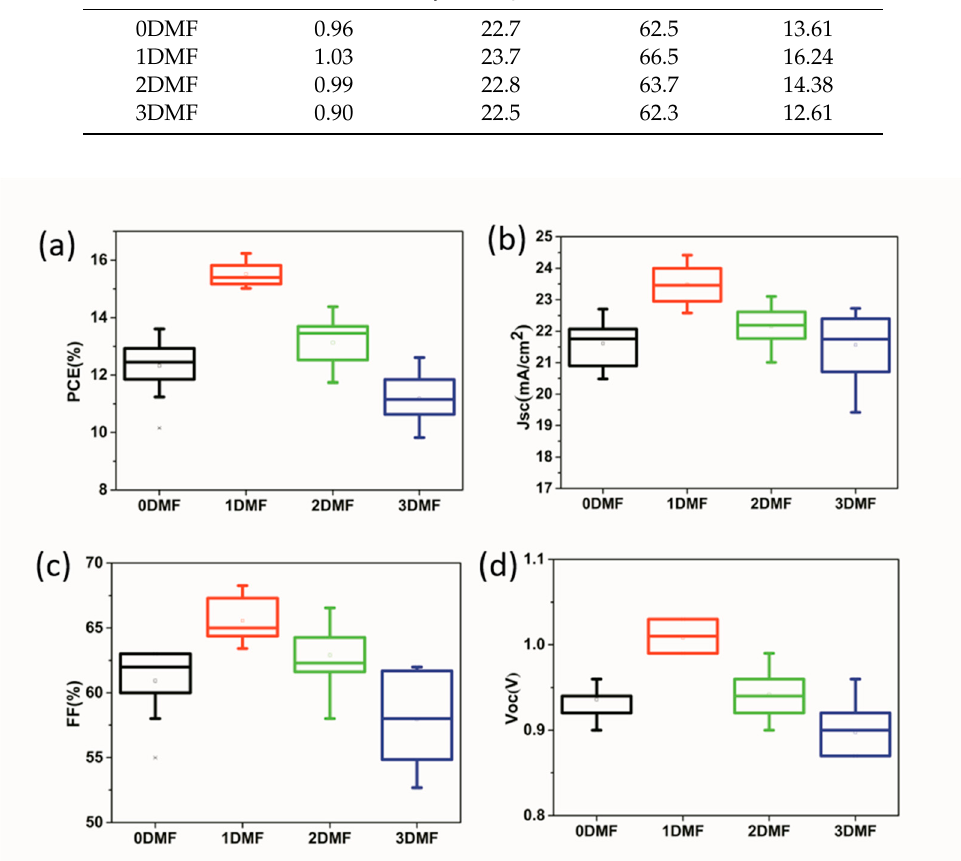
Figure 9. Photovoltaic statistics for the PSCs by four precursors. ( a ) PCE; ( b ) Jsc; ( c ) FF, and ( d ) Voc.